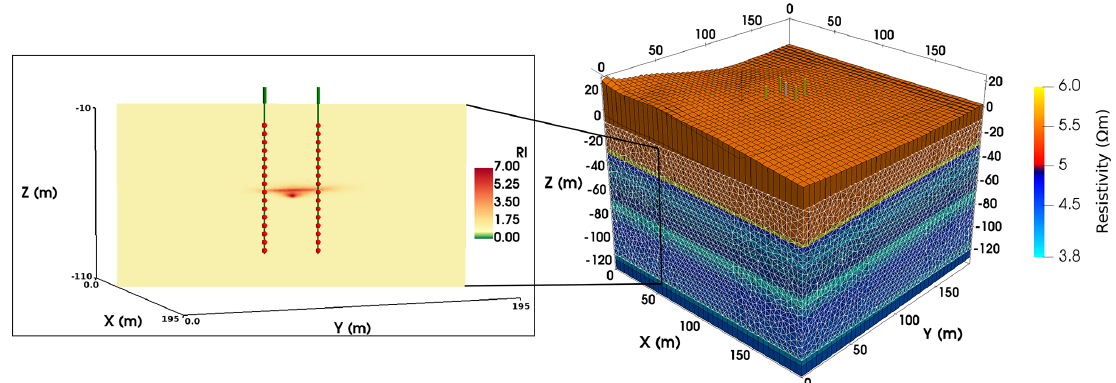
Figure 4. Reservoir model grid populated with electrical resistivity values and locations of the monitoring and injection wells. The injection well is located at x , y = 92 . 5m. The green wire frame represents the outer surface of the unstructured inversion region. Shown as well, is a slice through the 3D reservoir model between well M2 and M1 in terms of the resistivity index R/R 0 after the injection of 23t of CO 2